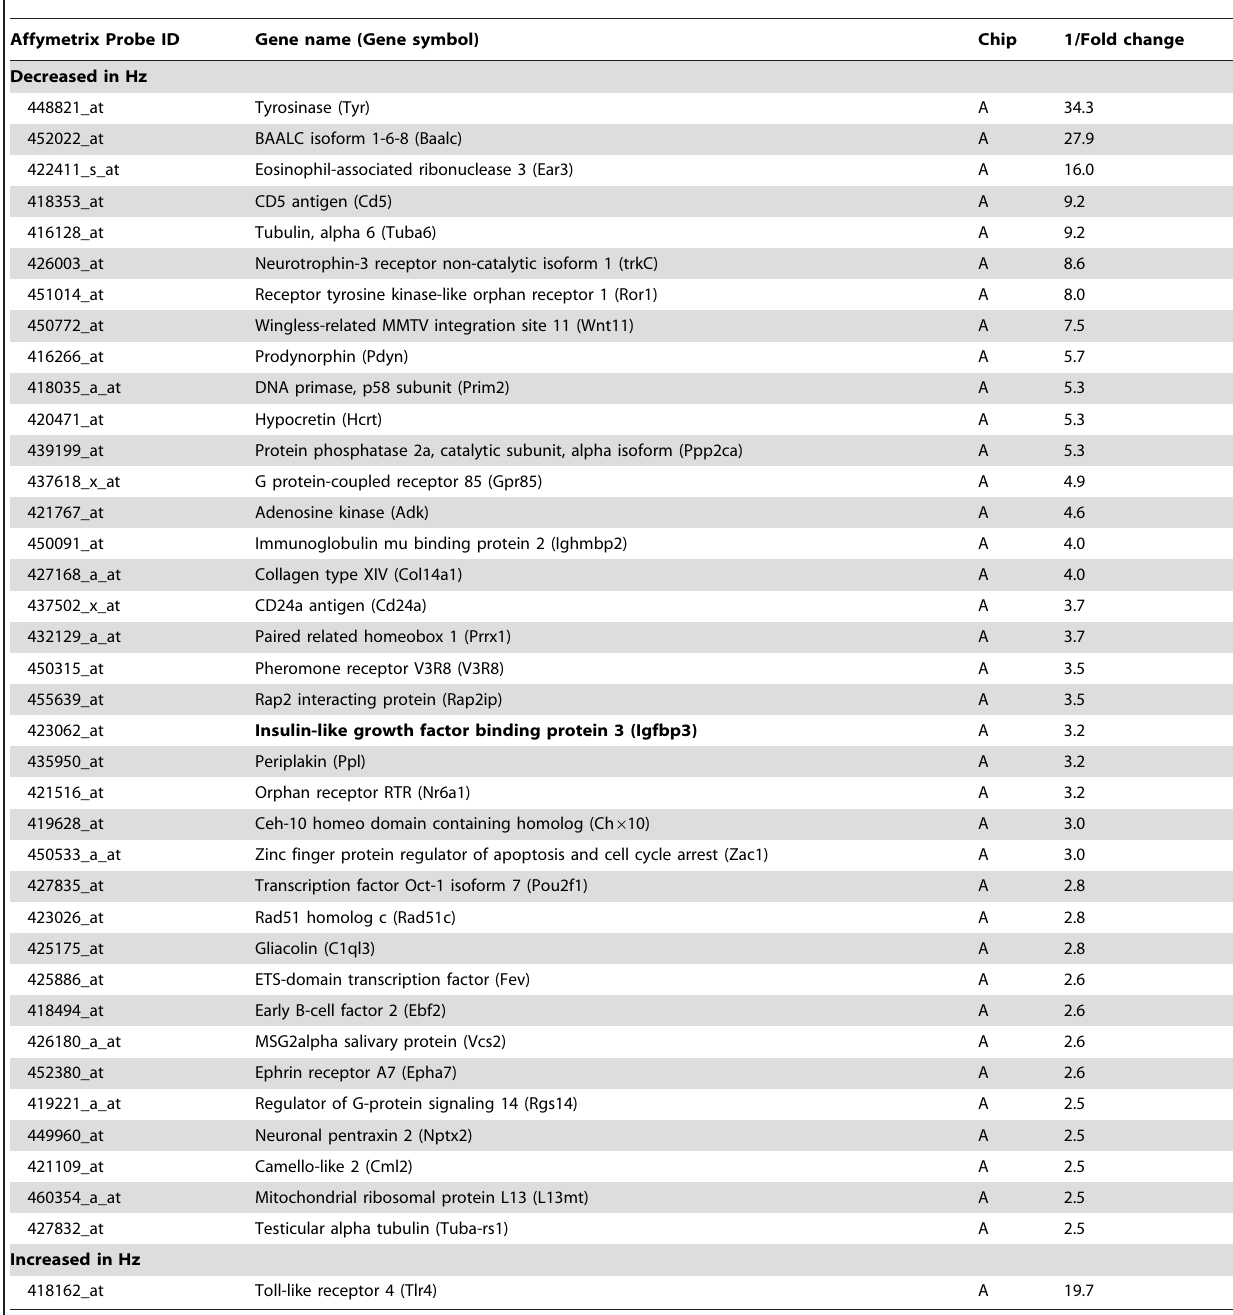
Table 3. Mouse transcripts most differentially dysregulated in the perifornical area of ataxin-3 transgenic animals versus control mice.